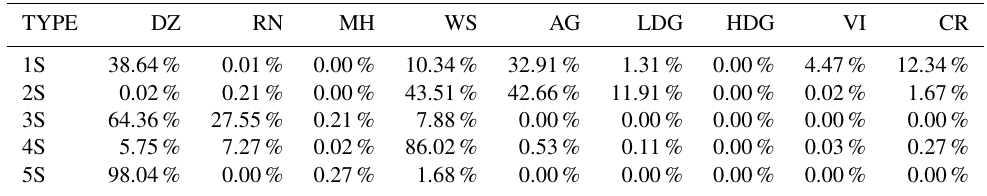
Figure 6. Clustering hydrometeor classification retrieved from the X-band radar at 12:07UTC on 21 February 2014, along the azimuth 290 ◦ . (a) With temperature constraint, (b) without temperature constraint. Table 3. Confusion matrix comparing the clustering outputs from the stratiform region of the wet season and hydrometeor species retrieved from the adapted fuzzy